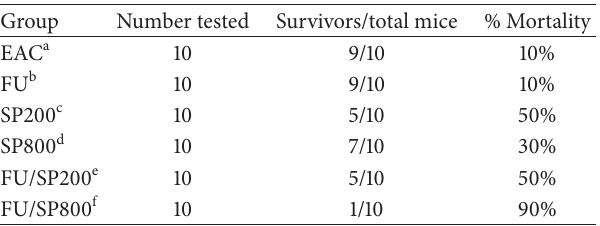
Table 1: Effects of 5-fluorouracil (20mg/kg), spirulina (200 or 800 mg/kg), and their combination on the survival of EAC tumor- bearing mice.